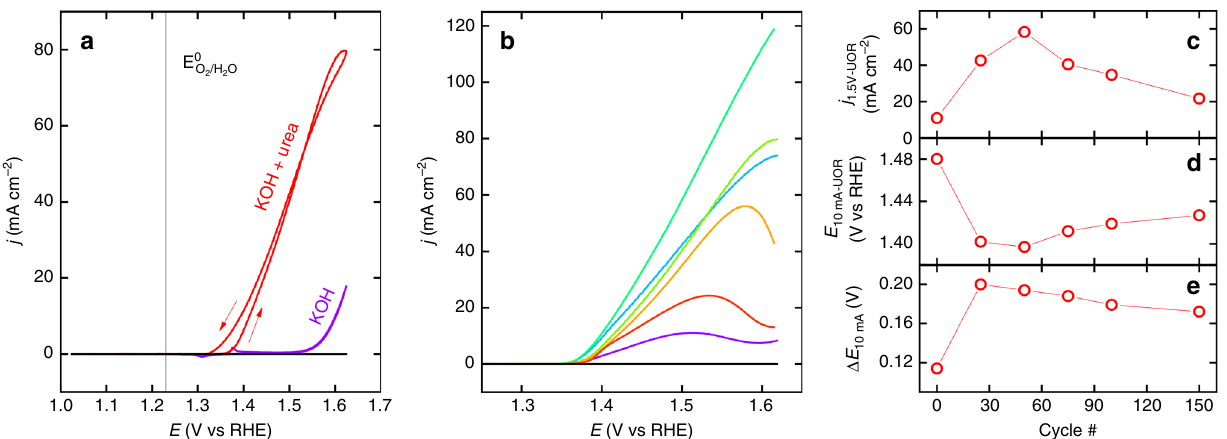
Fig. 4 Electrocatalytic activity of p + -Si/SiO x /Ni/NiFePB anodes. a CVs of (black) p + -Si/SiO x in 1 M KOH, (purple) p + -Si/SiO x /Ni/NiFePB- 75cy in 1 M KOH and in (red) p + -Si/SiO x /Ni/NiFePB- 75cy in 1 M KOH + 0.33 M urea, the arrows indicate the sweep direction. b LSVs of (black) p + -Si/SiO x and p + -Si/SiO x / Ni/NiFePB, prepared with different number of cycles ((purple) 0cy , (light blue) 25cy , (cyan) 50cy , (light green) 75cy , (yellow) 100cy , (red) 150cy ) in 1 M KOH + 0.33 M urea. c – e Values of c j 1.5V-UOR , d E 10mA-UOR , and e Δ E 10mA measured for p + -Si/SiO x /Ni/NiFePB as a function of the number of cycles. All voltammograms were recorded at 10 mV s − 1 in the